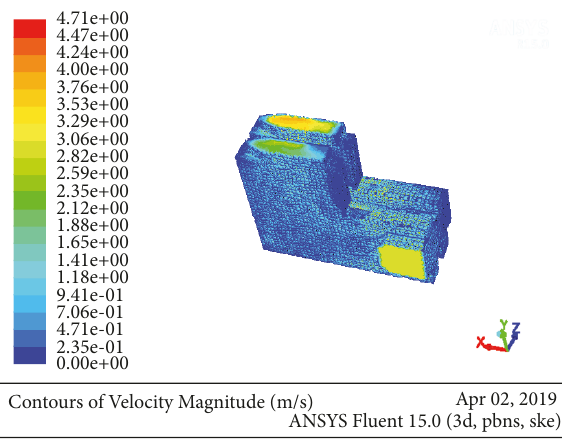
Figure 24: The velocity distribution of support in Test FS1.